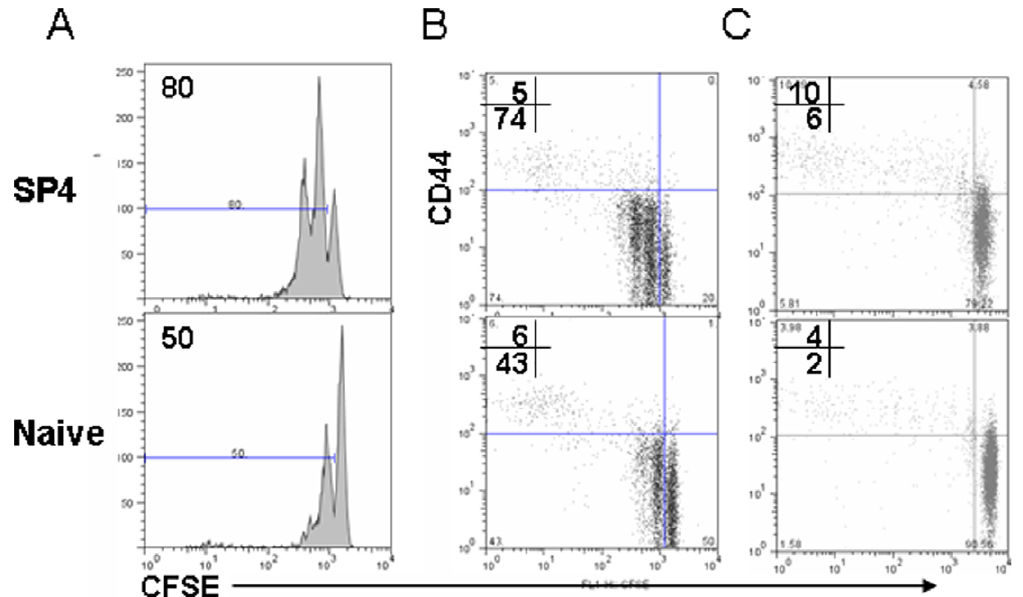
Figure 4. Comparison of lymphopenia-induced proliferation of pre-RTEs and naı¨ve T cells. Purified SP4 thymocytes, and CD4 + naı¨ve T cells from lymph nodes of C57BL/6 mice were labeled with CFSE and adoptively transferred into sub-lethally irradiated (600 rads) adult C57BL/6 mice (A and B) or unirradiated 9-day old C57BL/6 mice (C). Donor T cells from lymph nodes (LN) of the hosts were analyzed for CD44 expression and CFSE dilution (proliferation) 4 days (irradiated mice) and 14 days (unirradiated young mice) later. The numbers in the plot display the percentage of cells